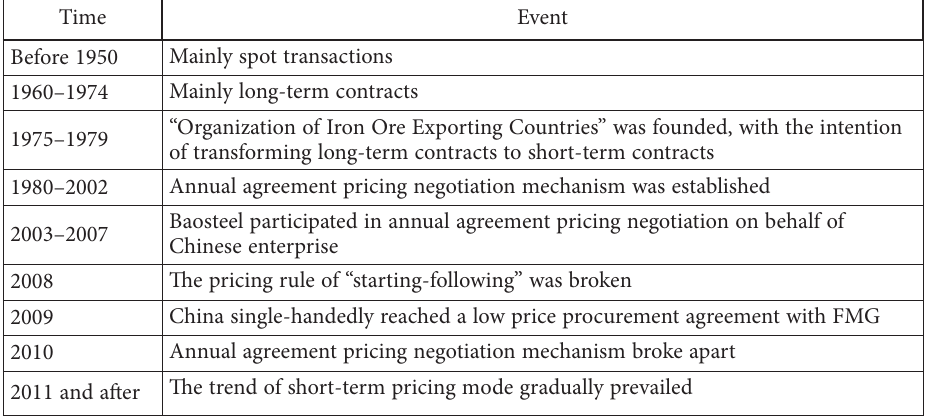
Table 1. Evolution process of the iron ore pricing mechanism